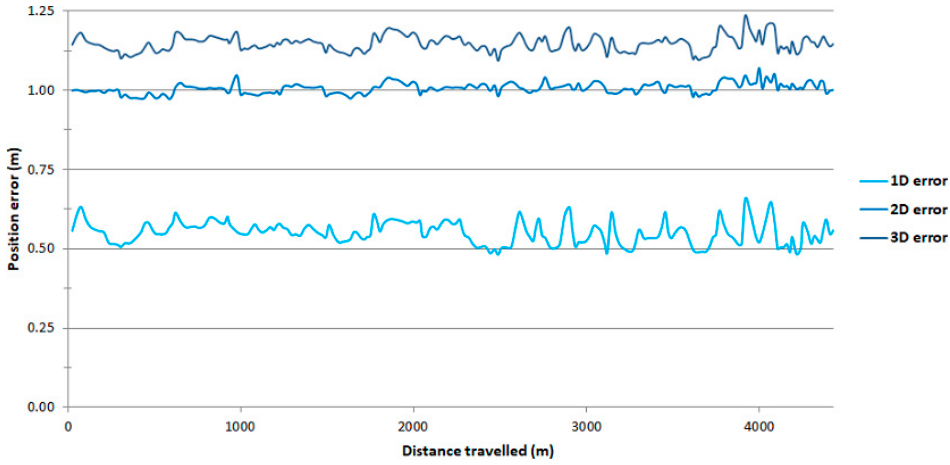
Figure 9. Variability of the 1D, 2D and 3D position errors recorded using the Ellipse-D system in the DGPS mode on route no. 1.